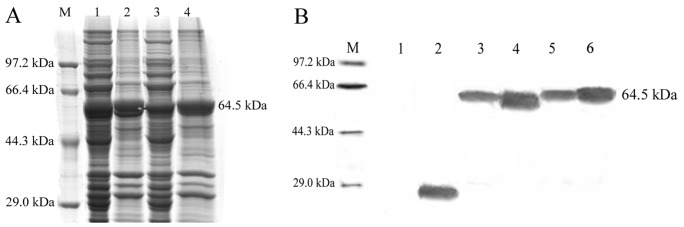
Expression of AhDGAT2–GST fusion proteins after induction with 1 mM IPTG at 37°C for 6 h.M: Protein molecular weight marker. (A) Lanes 1, 3: AhDGAT2a–GST and AhDGAT2b–GST extracted from the cytoplasmic fraction; Lanes 2, 4: AhDGAT2a–GST and AhDGAT2b–GST extracted from inclusion bodies. (B) Western blot analysis of the AhDGAT2–GST fusion proteins using anti-GST tag monoclonal antibody. Lane 1: Wild-type E. coli Rosetta (DE3) strain; Lane 2, GST expression from the empty-vector transformed strain; Lanes 3, 5: AhDGAT2a–GST and AhDGAT2b–GST from the cytoplasmic fraction; Lanes 4, 6: AhDGAT2a–GST and AhDGAT2b–GST from inclusion bodies.